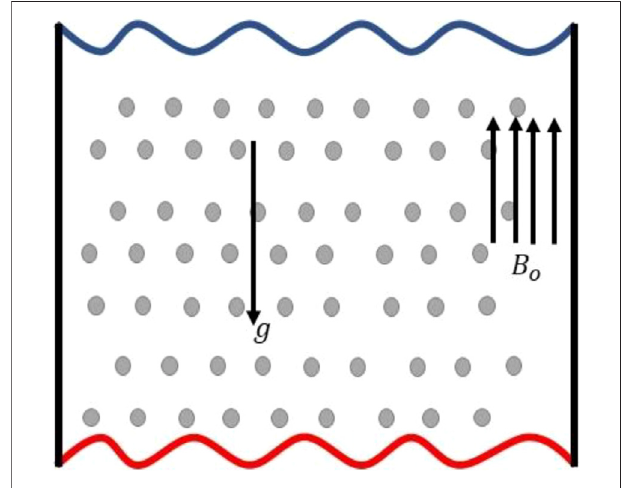
FIGURE 1 | Schematic diagram of the